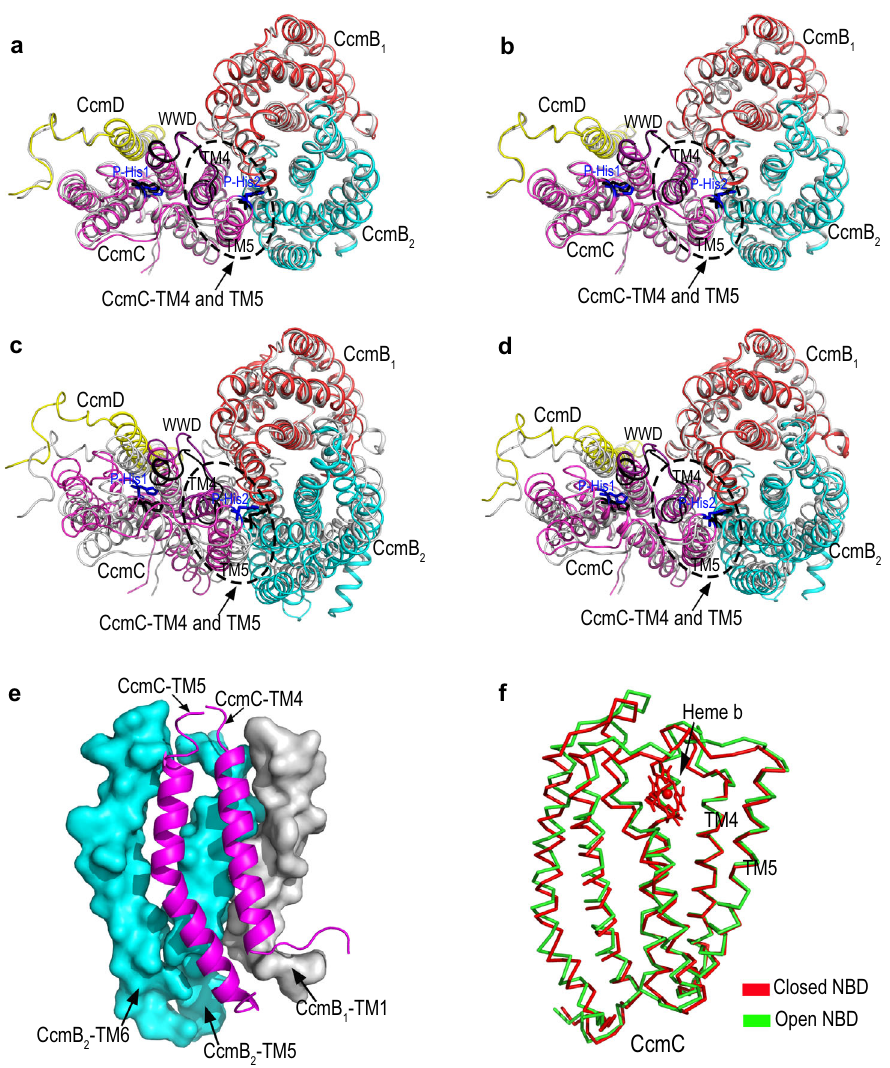
Fig. 4 | Superposition of the closed NBD state of CcmABCD bound with two ATPs with other states. The two structures of each panel ( a – d ) are aligned with CcmB 1 .Ineachpanel,P-His1andP-His2ofclosedNBDstatearerepresentedinblack sticks, and in blue sticks for other states. The regions of CcmC-TM4, TM5, and P-His2 are marked by elipse. a CcmABCD closed NBD state bound with two ATPs (gray) and closed NBD state bound with two inorganic phosphates (colored). b CcmABCD closed NBD state bound with two ATPs (gray) and closed NBD state boundwithtwoAMP-PNPs(colored). c CcmABCDclosedNBDstateboundwithtwo ATPs (gray) and ligand-free open NBD state (colored). There is a signi fi cant